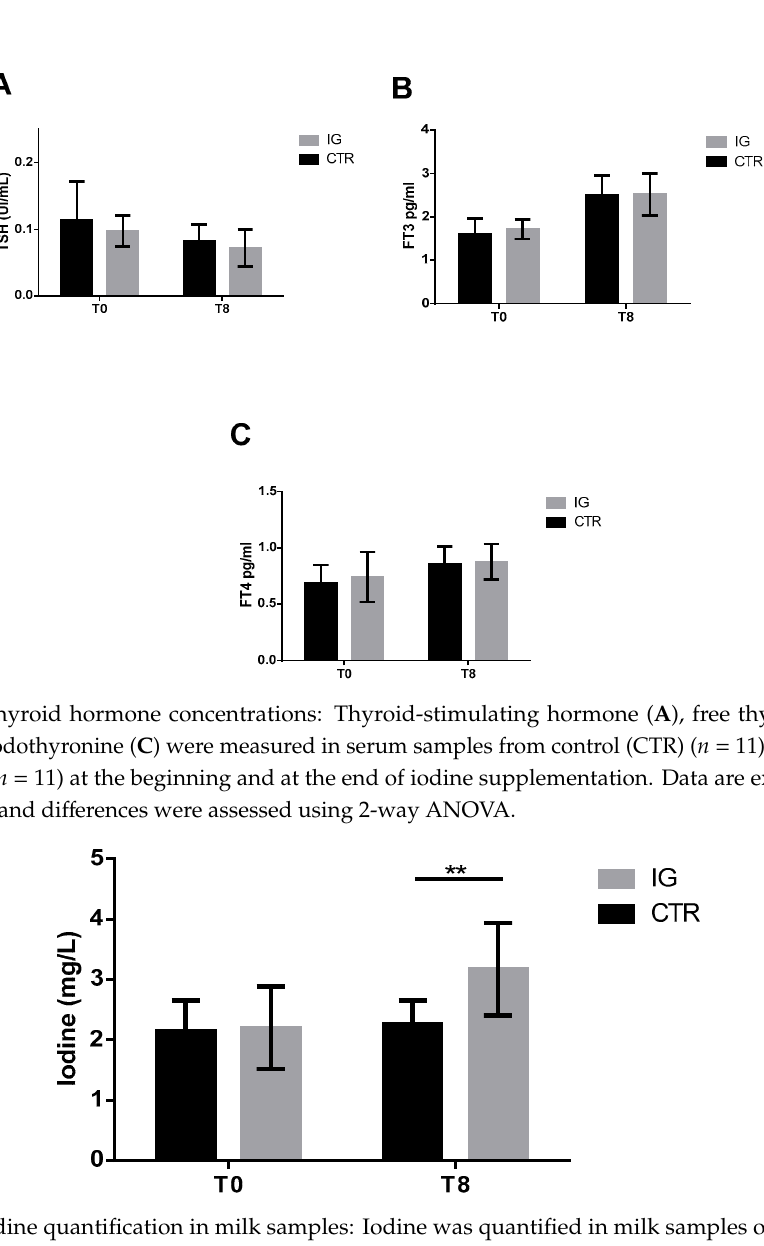
Figure 2. Iodine quantification in milk samples: Iodine was quantified in milk samples of both CTR ( n = 11) and IG ( n = 11) at the beginning and at the end of iodine supplementation. Data are shown as mean ± SD, and differences were assessed using 2-way ANOVA. ** p -value < 0.01.